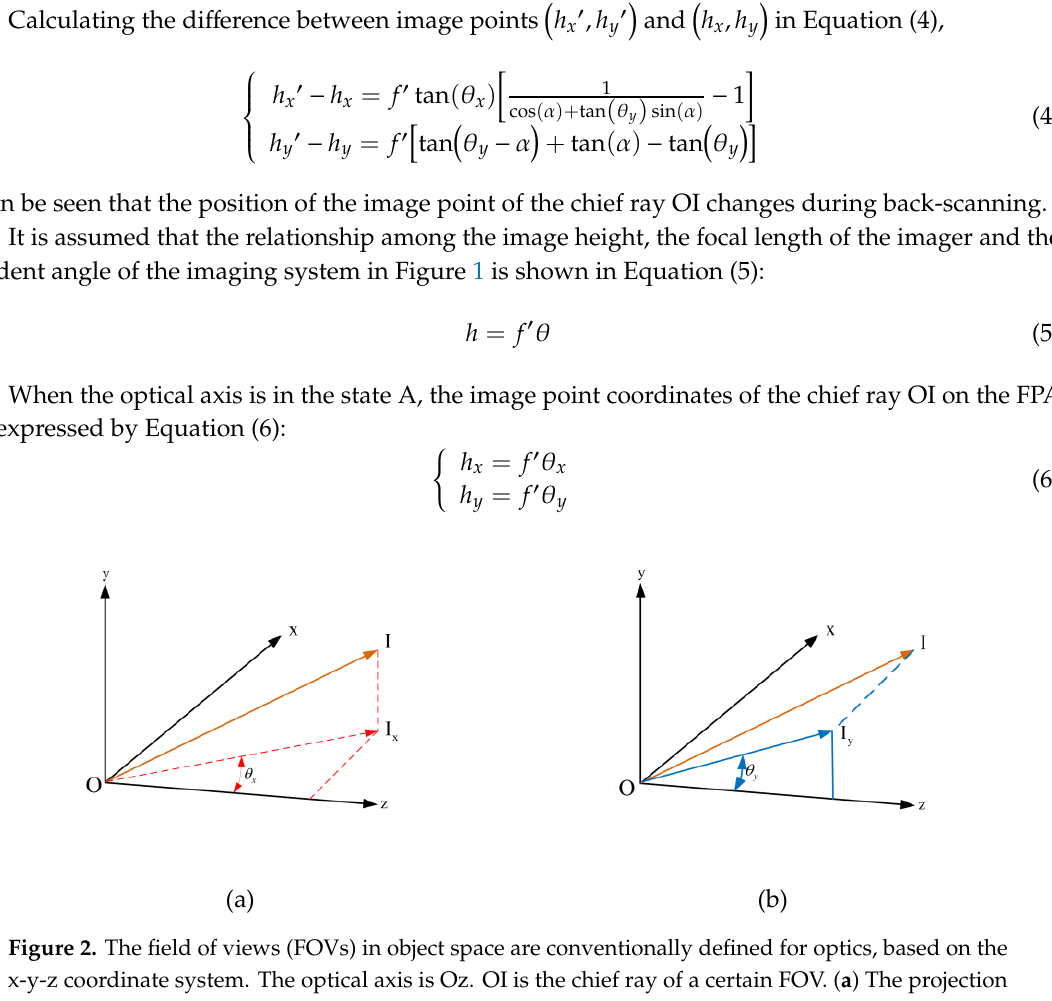
h is the image height in y direction. y